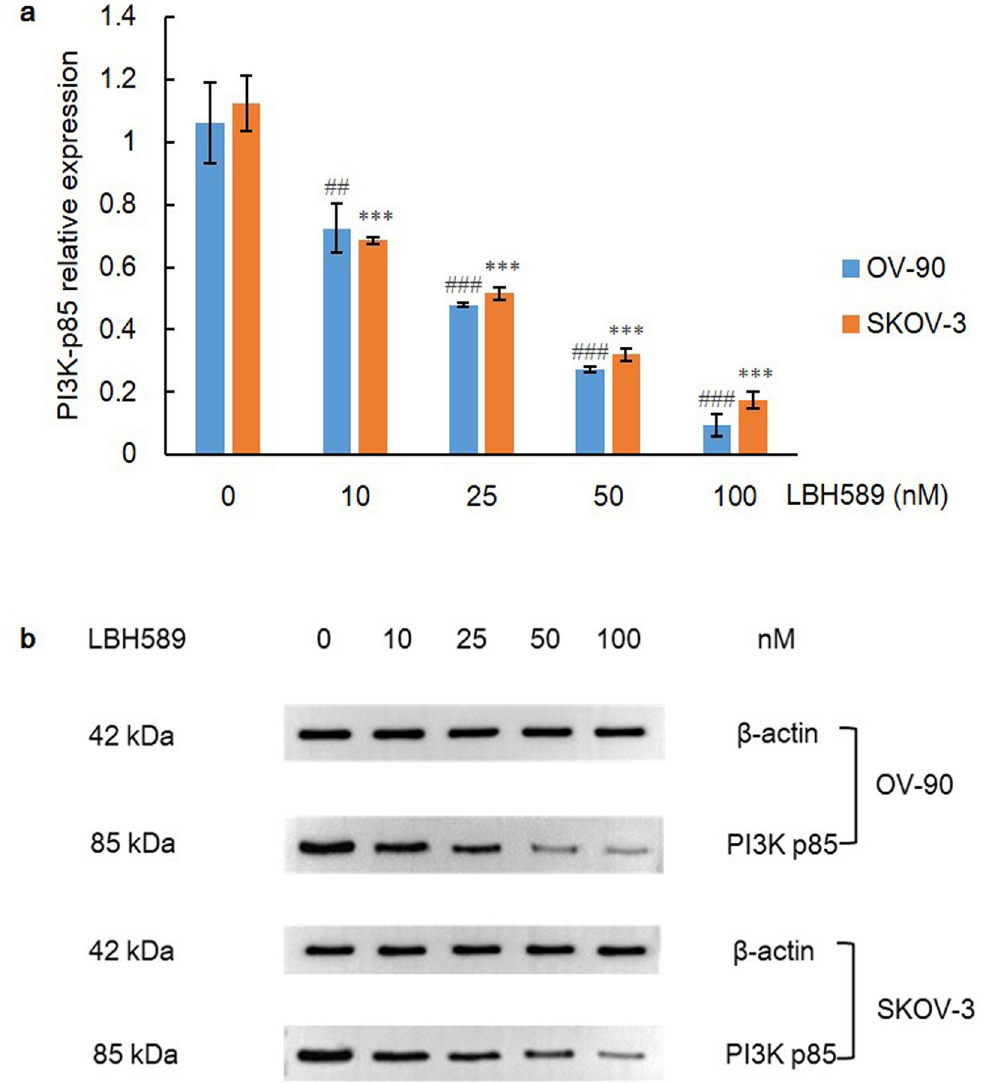
Fig 3. PI3K expression after LBH589 treatment for 48 h. A) LBH589 suppresses expression of PI3K in OV-90 and SKOV-3 cell lines. Data are shown as mean ± SD of at least three individual experiments. ( � P < 0.05, �� P < 0.01, ��� P < 0.001 vs. SKOV-3 control (0.1% DMSO); # P < 0.05, ## P < 0.01, ### P < 0.001 vs. OV-90 control (0.1% DMSO)). B) The expression of PI3K was assessed by western blot analysis after LBH589 treatment for 48 h. The equal protein loading is shown by detection of β -actin. The figures show representative blots which were cropped from original images. the escalating gradient of LBH589 in both cell lines (P = 0.000) (Fig 5). To further support the idea that HDACi-induced degradation of HIF-1 α is independent of pVHL, we assessed and compared the expressions of HIF-1 α among groups of VHL inhibition (VH289, 10 μ M; pur- chased from Cambridge, USA), HDAC inhibition (LBH589, 100 nM), HDAC plus VHL co- inhibition (VH298, 10 μ M plus LBH589, 100 nM) and vehicle control (0.1% DMSO) for 48 h. As a result, HIF-1 α expressions were significantly different in group of HDAC inhibition and group of VHL inhibition as compared to control group (P < 0.05) via independent-sample t test. However, no remarkable difference was found between group of HDAC inhibition and group of HDAC plus VHL co-inhibition, suggesting that HDACi-induced HIF-1 α degradation